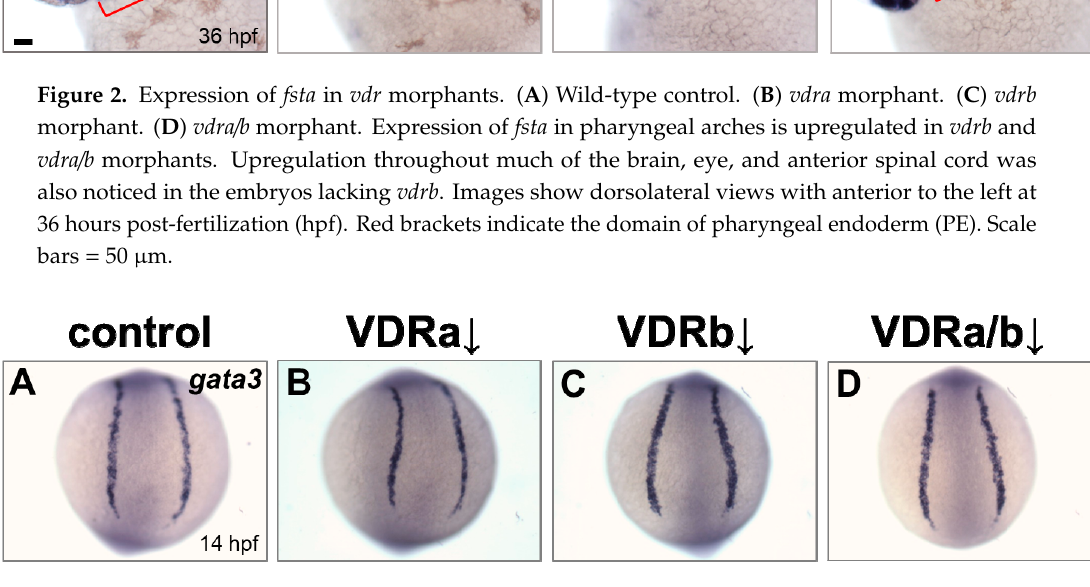
Figure 3. Expression of gata3 in vdr morphants. ( A ) Wild-type control. ( B ) vdra morphant. ( C ) vdrb morphant. ( D ) vdra/b morphant. Images show posterior views at 14 hpf.